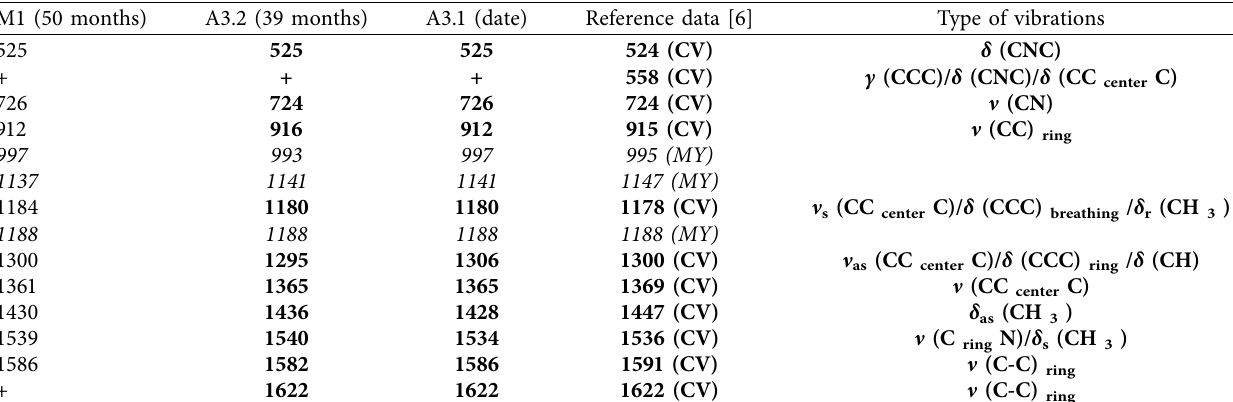
Table 3: Peak wavelength number (cm − 1 ) and reference data for reference dyes and samples M1, A3.2, and A3.1.